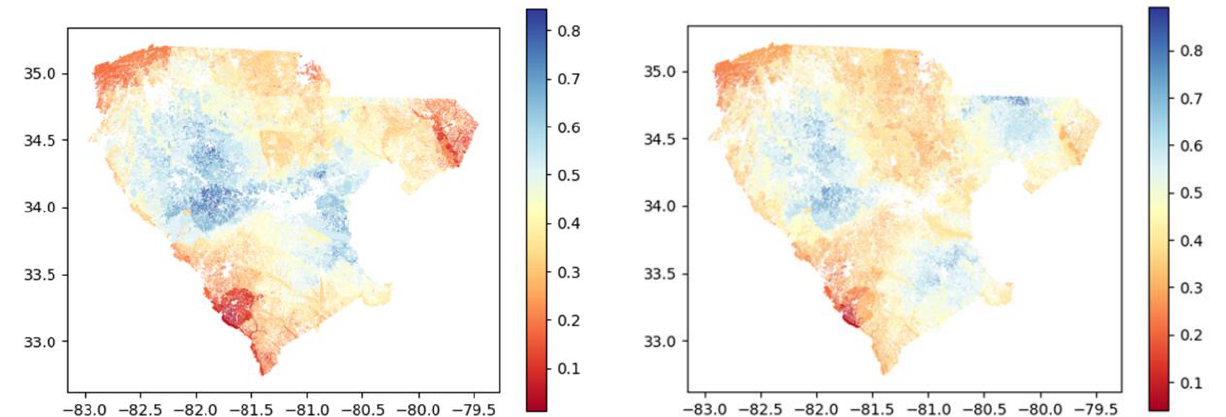
Figure 10. SSI integrated with transportation analysis using K-means ( left ) and graph theory ( right ).